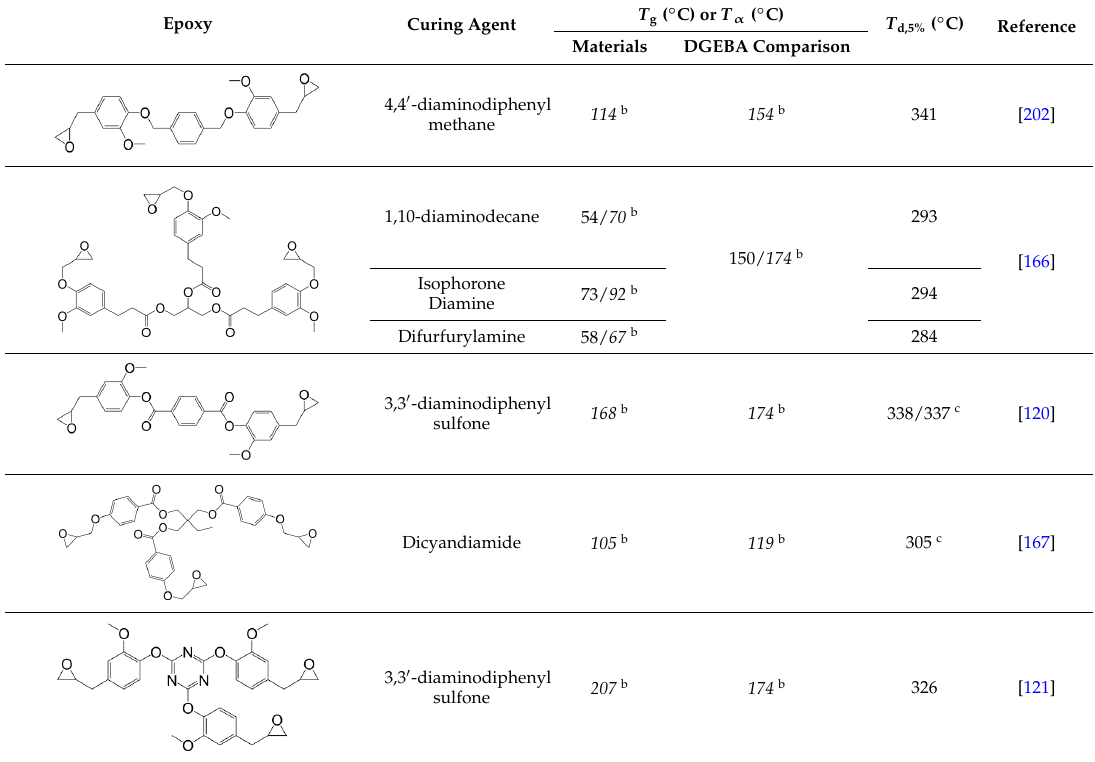
b T α measured by DMA at the maximum of